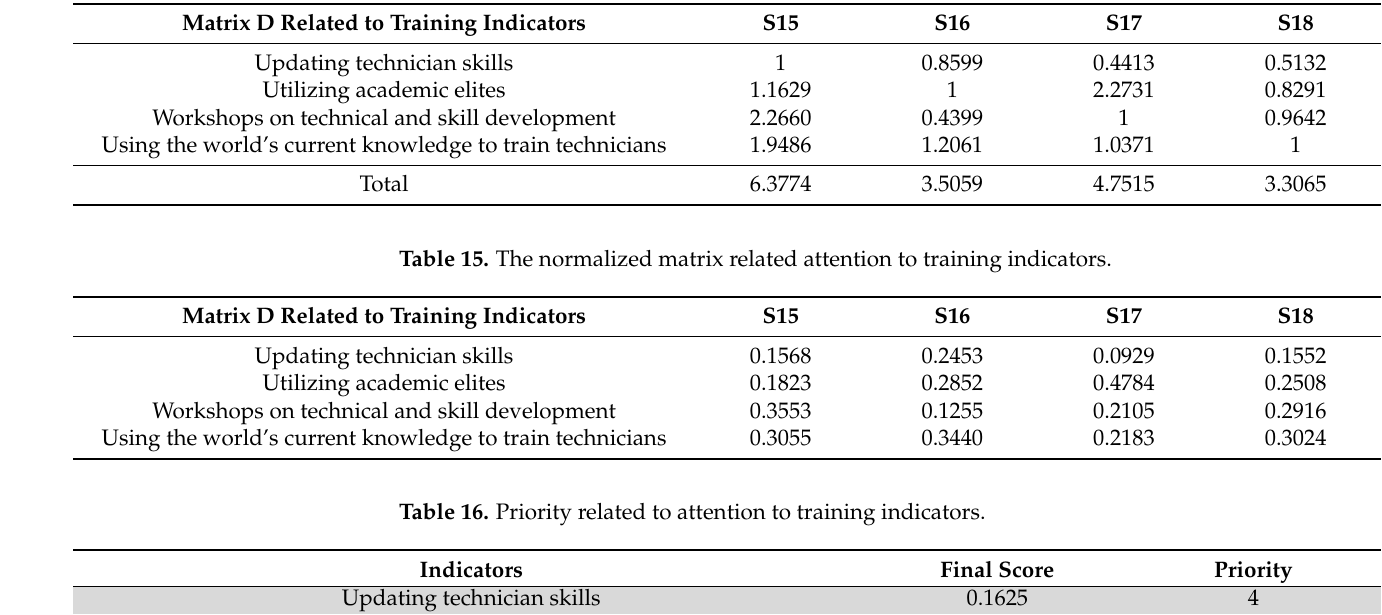
Table 14. Pairwise comparison matrix related to attention to training indicators.